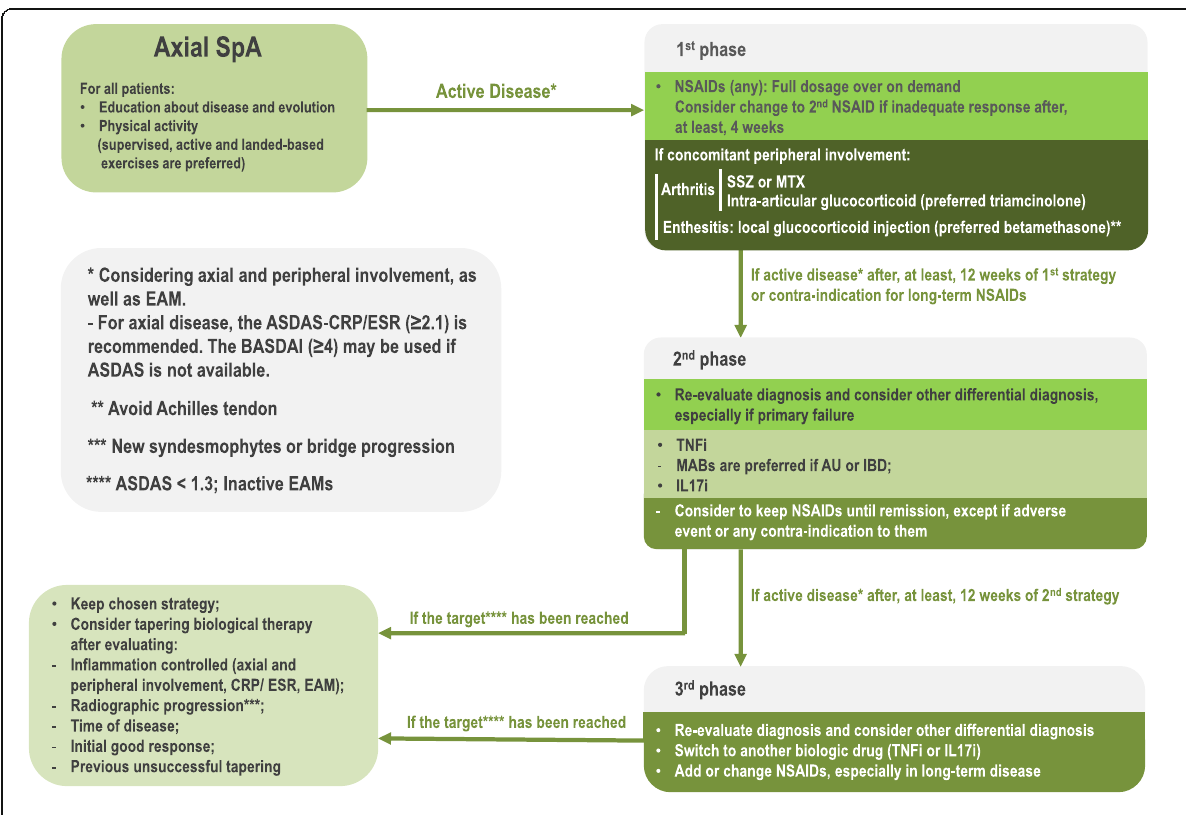
Fig. 1 2019 Brazilian Society of Rheumatology algorithm for axial SpA